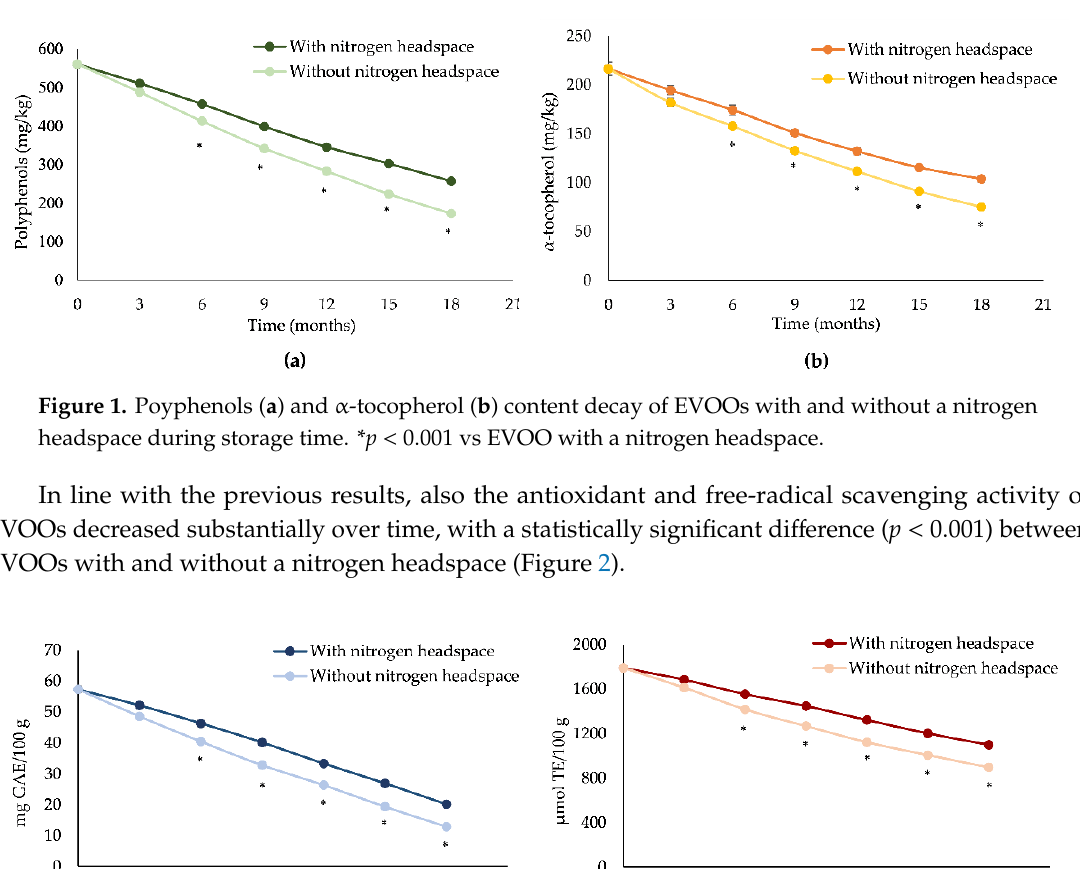
Figure 1. Poyphenols ( a ) and α-tocopherol ( b ) content decay of EVOOs with and without a nitrogen headspace during storage time. * p < 0.001 vs EVOO with a nitrogen headspace.